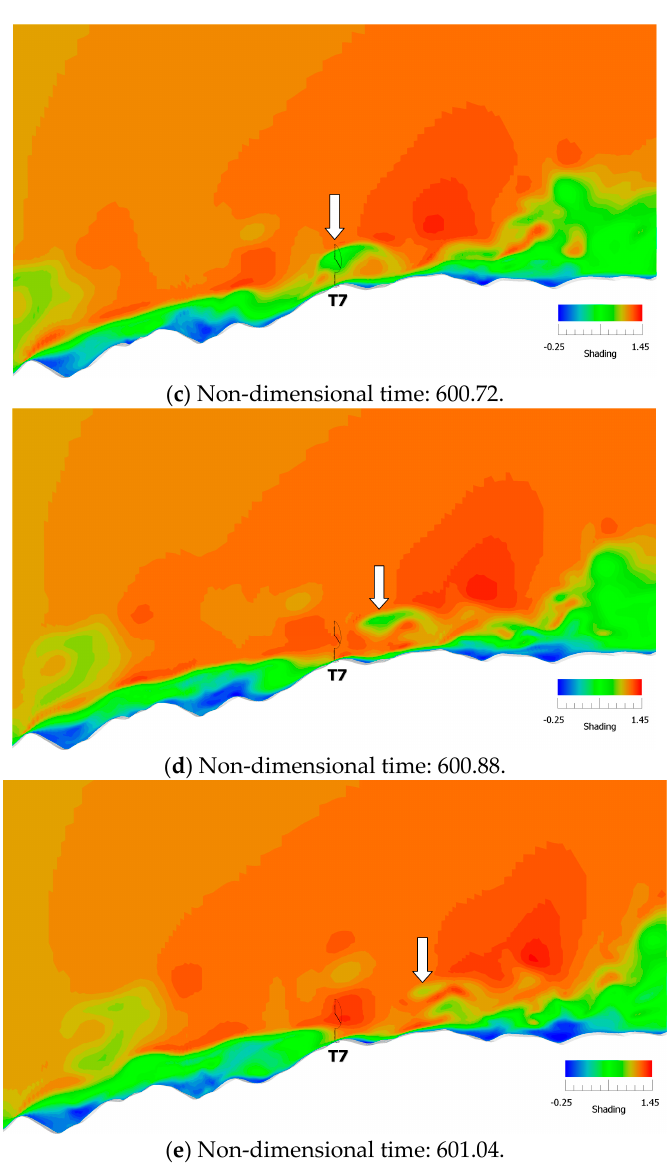
Figure 13. Temporal change of the streamwise (x) wind velocity field in the vertical cross-section that includes the site of T7.